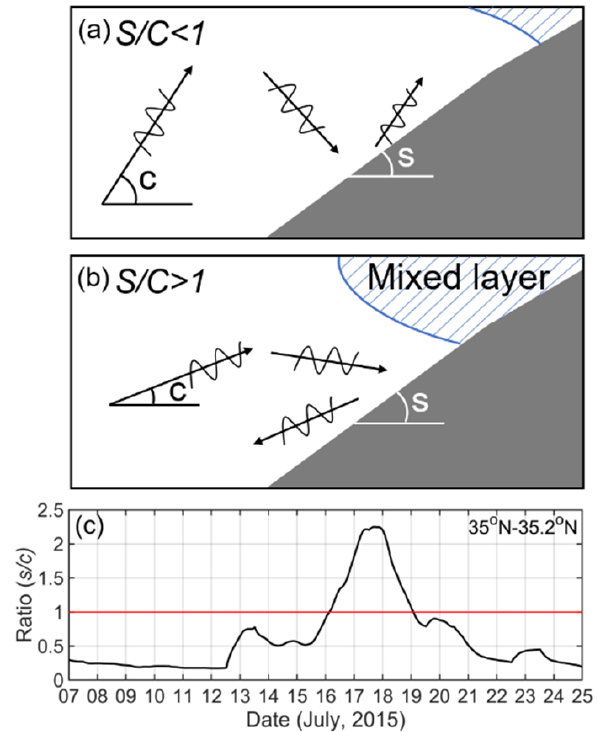
Figure 8. Schematic diagrams for reflection conditions ( a ) when the energy of internal tides can be transmitted to the coast ( S / C < 1) and ( b ) when it can be reflected seaward ( S / C > 1). ( c ) S / C ratio calculated using DR_M outputs by averaging between 35 ◦ N and 35.2 ◦ N along the magenta line in Figure 7. The S / C ratio was calculated using the stratification conditions from the DR_M output and the slope from 35.0 ◦ N to 35.2 ◦ N, where the semidiurnal internal tidal energy is higher near the bottom (Figure 7f). The timeseries of the ratio (Figure 8c) reveals that C becomes gentle (less steep) during 16–18 July, when stratification is enhanced above the bottom due to the deepened pycnocline in the adjacent area. This creates a condition for the seaward reflection of semidiurnal internal tides ( S / C > 1). In the other periods, the semidiurnal internal tides propagate landward. This result accounts well for the variation in semidiurnal internal tides observed by the ADCP and the simulated convergence